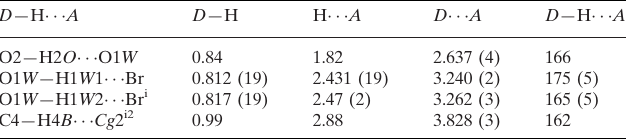
material for publication: SHELXTL